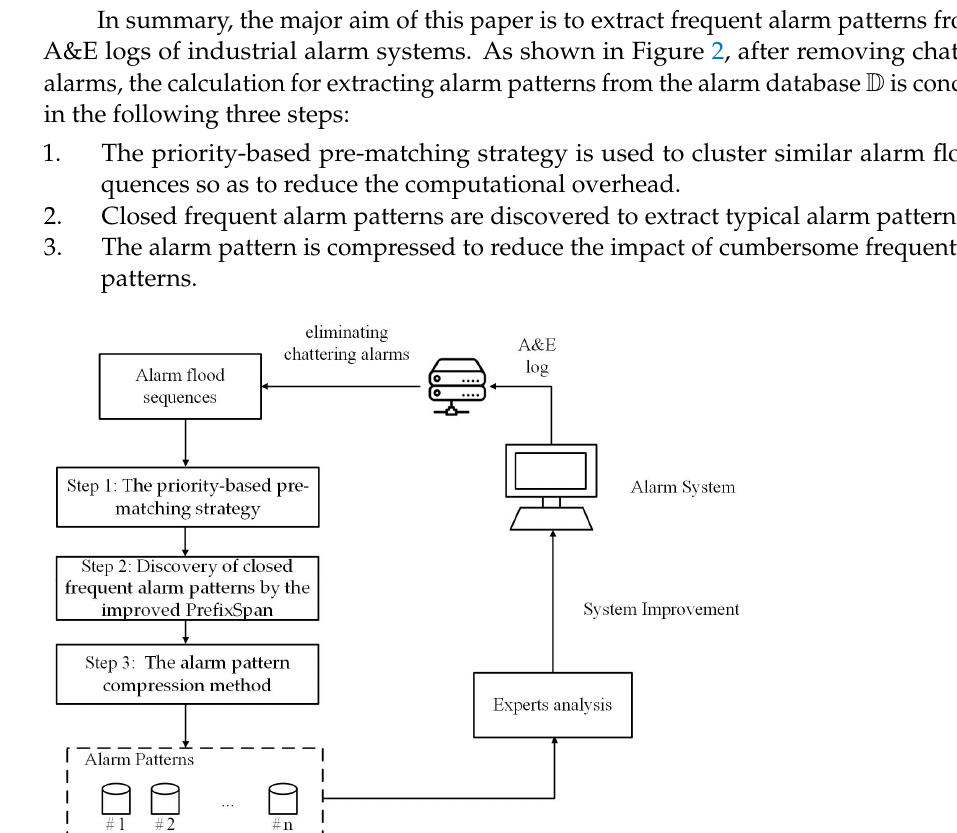
Table 4. Typical alarm priorities of industrial alarm systems.